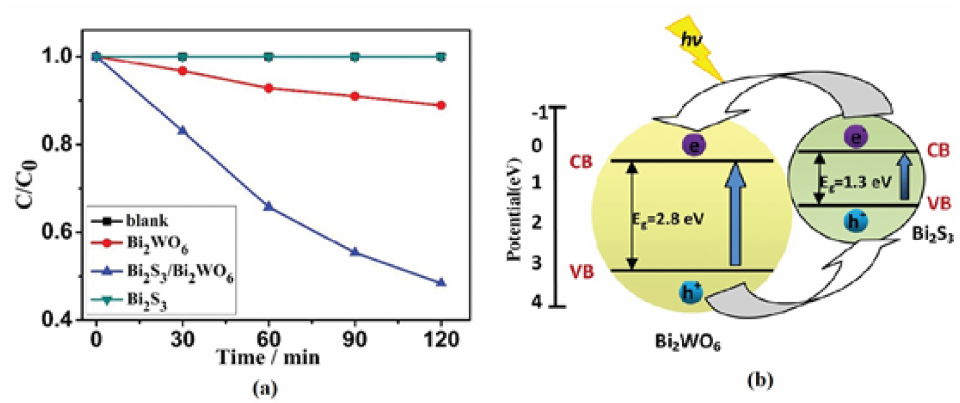
Figure 11. ( a ) Photocatalytic degradation of phenol under visible light irradiation as a function of time; and ( b ) Diagram for energy band levels of Bi 2 S 3 /Bi 2 WO 6 composites and the possible charge separation process. Reproduced and adapted with permission from ref. [78]. Copyright 2012 American Chemical